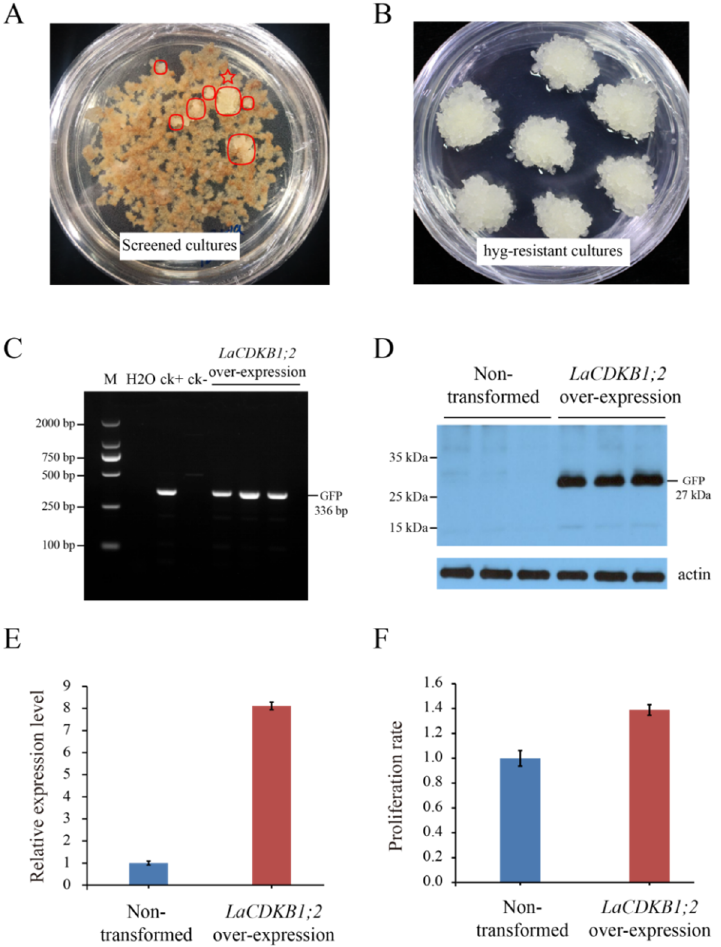
Figure 7. Generation and characterization of L. kaempferi transgenic ( LaCDKB1;2 over-expression) cultures. ( A ) Several clumps of hygromycin-resistant S287 cultures (indicated by circles) were obtained in a solid proliferation medium with 400 mg/L cefotaxime and 5 mg/L hygromycin. ( B ) One clump of hygromycin-resistant S287 culture (indicated by a five-pointed star) survived and was proliferated in a solid proliferation medium with 5 mg/L hygromycin. ( C ) PCR amplification of the DNA fragment of GFP . M: 2000 DNA marker; ck+: positive control; ck–: negative control. ( D ) Expression of GFP assayed by Western blot, with actin as the internal control. ( E ) Expression of LaCDKB1;2 assayed by qRT-PCR, with LaEF1A1 as the internal control . ( F ) Cell proliferation rate in non-transformed and transgenic cultures . Data are presented as the mean ± SE. p -values for the expression of LaCDKB1;2 and the proliferation rate were generated to compare non-transformed and transgenic S287 cultures.